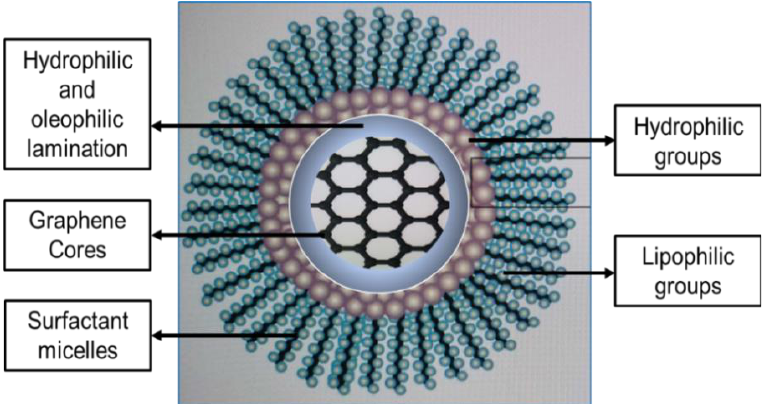
Figure 8. Effect of different mass concentrations on the performance of permeable cement stone.